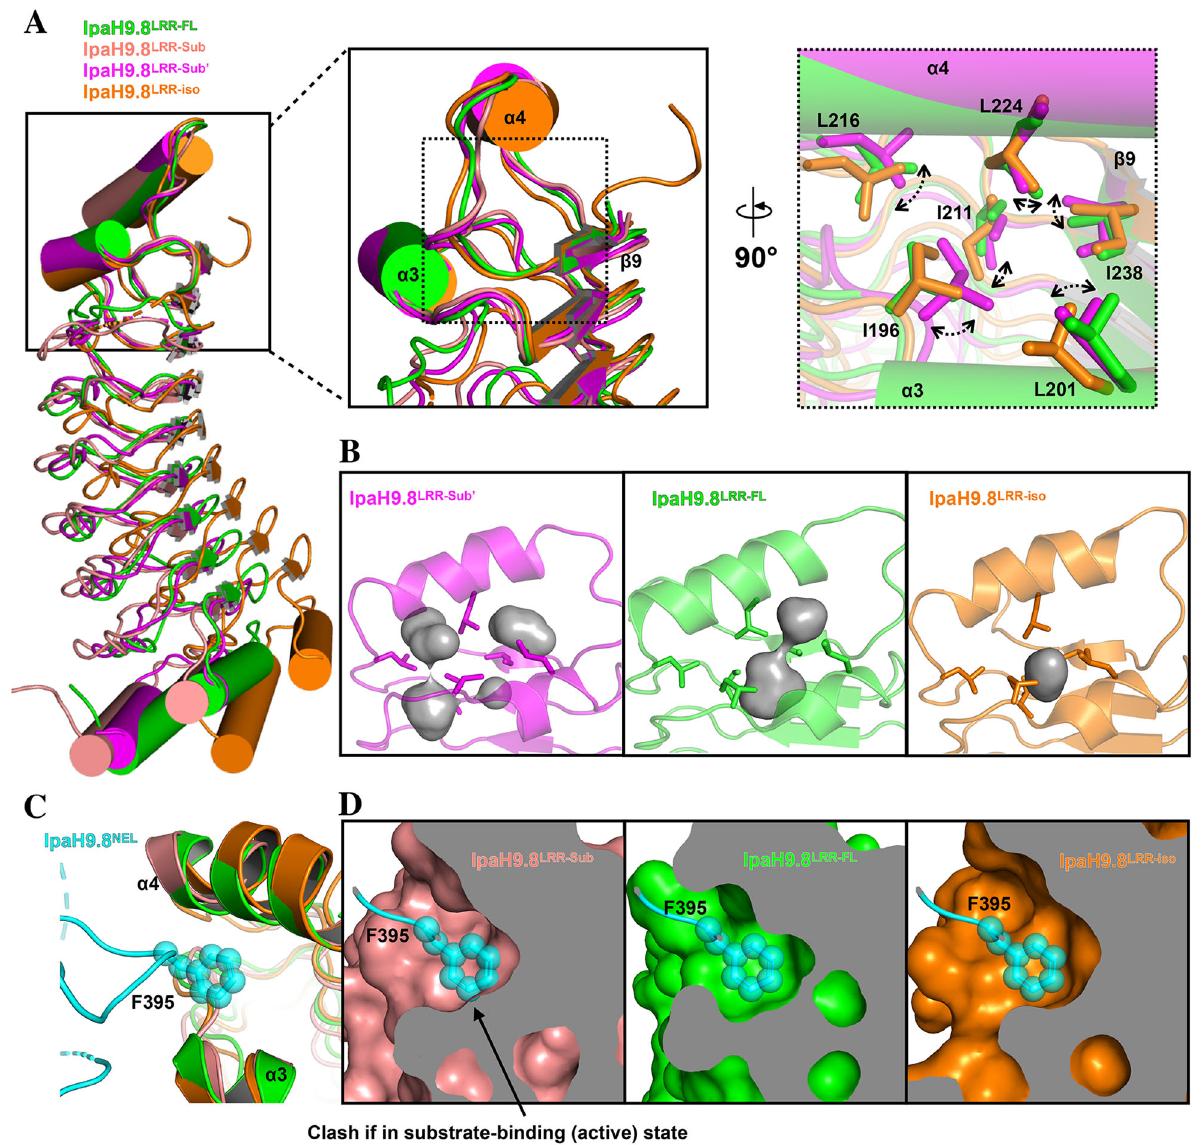
Fig. 5 Comparison of the hydrophobic pocket of LRR-CT in different IpaH9.8 LRR structures. A Left, superimposition of the structures of IpaH9.8 LRR-Sub , IpaH9.8 LRR-Sub ’ (PDBID: 6K2D), IpaH9.8 LRR-FL , and IpaH9.8 LRR-iso (PDBID: 5B0T) by LRR-CT with the LRR domains differentiated by colors. Middle, magni fi ed view of LRR-CTs in different IpaH9.8 LRR constructs as in left with α 3, α 4, and β 9 labeled. Right, further magni fi ed view of LRR-CTs in different IpaH9.8 LRR constructs as in middle but rotated ~90°. The hydrophobic cluster residues were labeled and represented as sticks. Arrows and dash lines indicate the movements of the hydrophobic cluster residues when bound to hGBP1. B The central cavities in the LRR-CT of IpaH9.8 LRR-Sub ’ (left), IpaH9.8 LRR-FL (middle) and, IpaH9.8 LRR-iso (right) were detected using Hollow and a 1.1-Å probe radius 71,72 . The cavities are shown as surface view and colored gray. C A close-up view of the LRR – NEL interface between IpaH9.8 FL with the LRR-CT of IpaH9.8 LRR-Sub ; IpaH9.8 LRR-iso superimposed to IpaH9.8 LRR-FL . The LRR and NEL of IpaH9.8 FL are colored green and cyan, respectively. The IpaH9.8 LRR-Sub and IpaH9.8 LRR-iso are colored salmon and orange, respectively. The α 3 and α 4 of LRR domain are labeled. Phe395 of IpaH9.8 FL is labeled and represented as stick and spheres. D The hydrophobic pocket of IpaH9.8 LRR-FL (left), IpaH9.8 LRR-Sub (middle) and IpaH9.8 LRR-iso (right) as in A